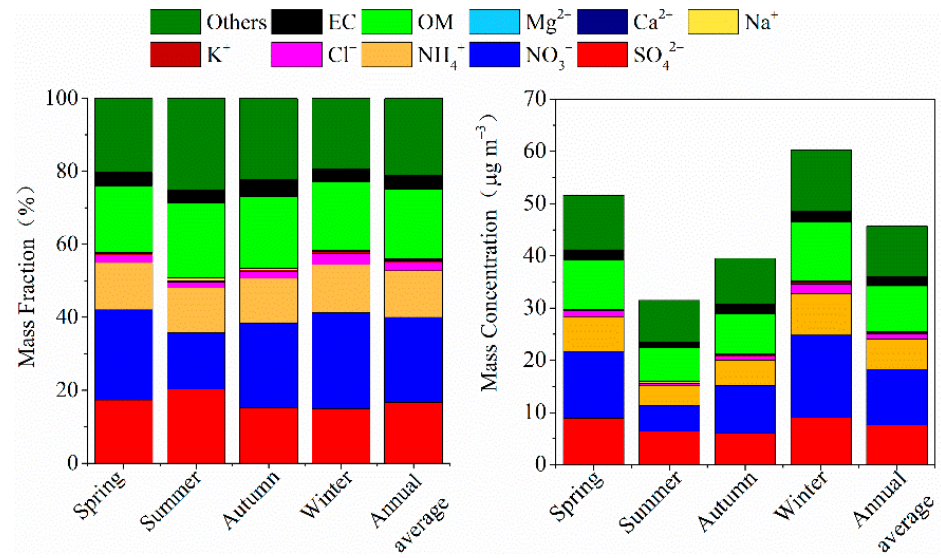
Figure 1. Concentrations and contributions of the chemical PM 2.5 components for each season. The seasonal distributions of all major chemical components of PM 2.5 , except Na + , were similar to PM 2.5 , with highest occurring in winter (Figure 2). The concentration of Na + was highest in summer (0.23 ± 0.26 µ g m − 3 ) and lowest in spring (0.09 ± 0.14 µ g m − 3 ), and the high level in summer was probably due to the influence of sea-salt aerosols brought by the Shanghai summer monsoon [16]. The seasonal variations of Ca 2+ and Mg 2+ were slightly similar, with the highest concentrations registered in winter (0.11 ± 0.15 µ g m − 3 and 0.03 ± 0.06 µ g m − 3 ), followed by spring (0.08 ± 0.13 µ g m − 3 and 0.02 ± 0.04 µ g m − 3 ). The relatively higher WS and lower RH in spring favored the resuspension of dust, and the more frequent dust storms from northwestern China in spring can transport dust to Shanghai over long distances, causing high Ca 2+ and Mg 2+ levels [26]. The concentration of K + showed the highest level in winter (0.38 ± 0.57 µ g m − 3 ), followed by